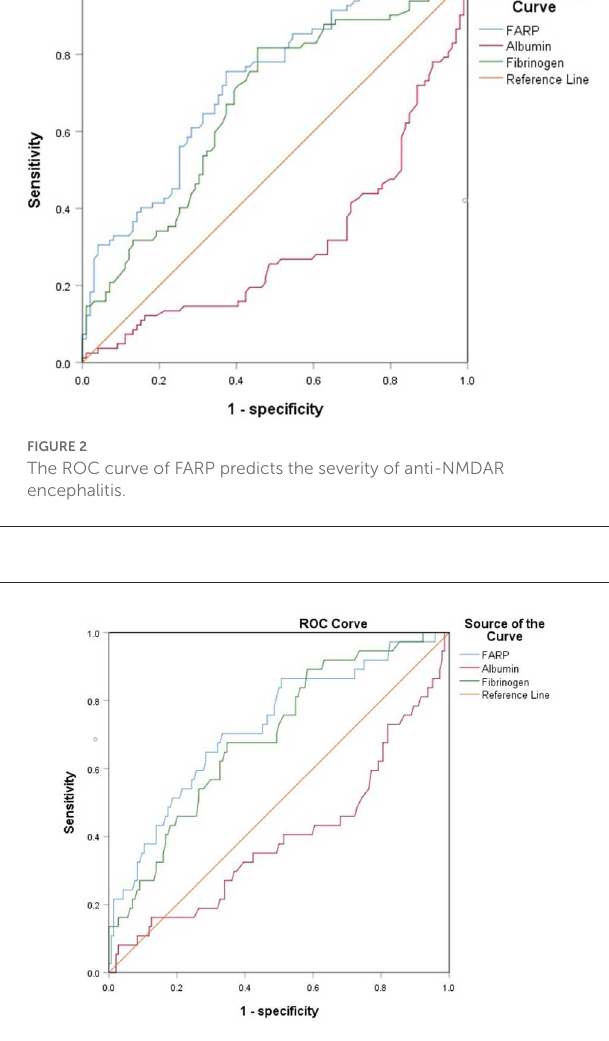
FIGURE3 The ROC curve of FARP predicts the prognosis of anti-NMDAR